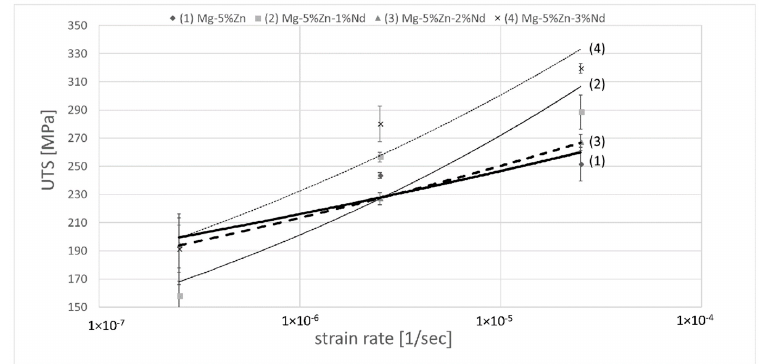
Figure 3. The ultimate tensile strength versus strain rate as obtained by the SSRT analysis for four different alloys.